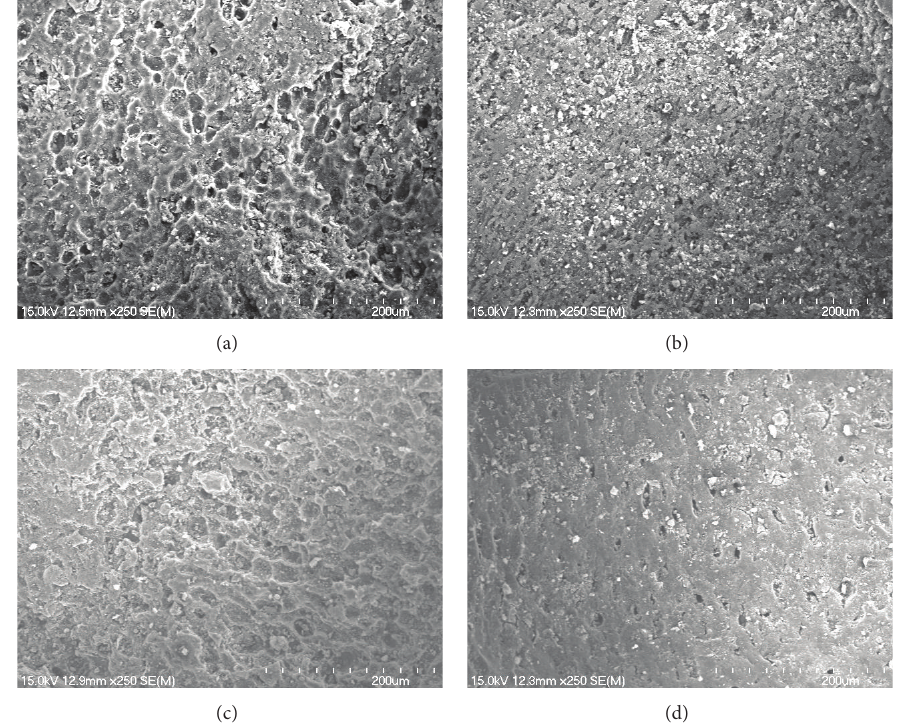
Figure 5: SEM images of MnO 2 -impregnated GAC with the different loading of MnO 2 (a) 0%; (b) 3%; (c) 5%; (d)